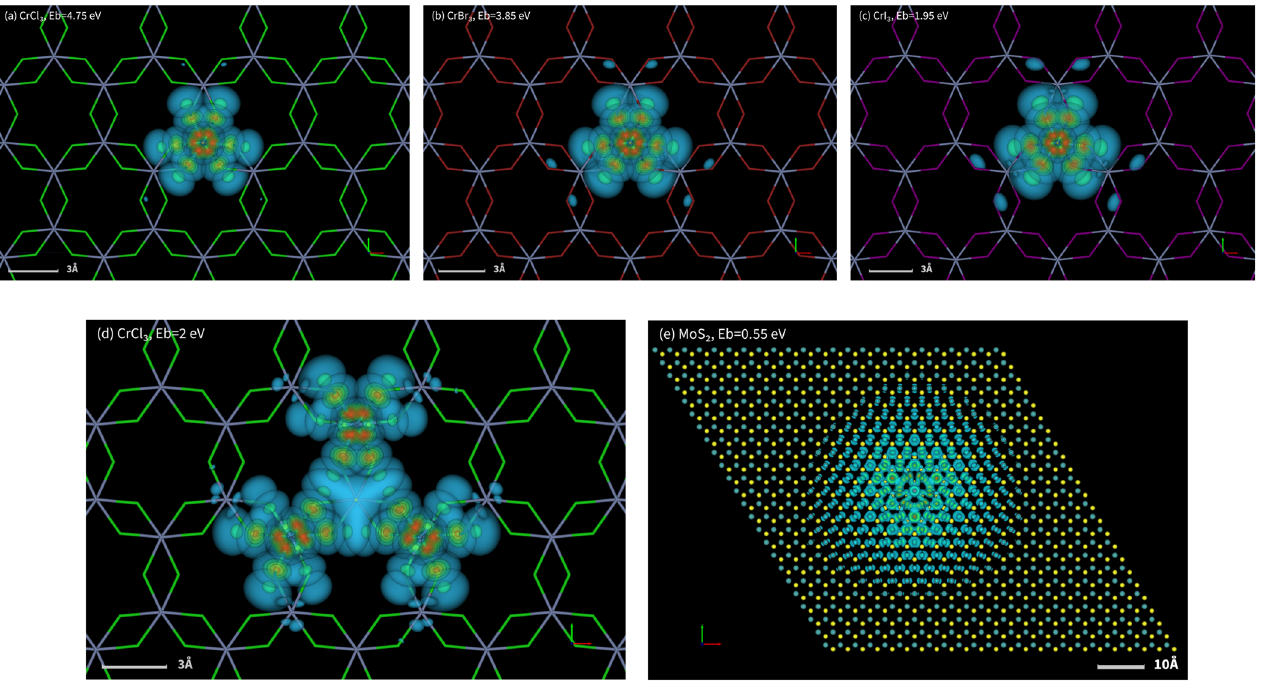
Fig. 9 Excitons in real space in CrX 3 and MoS 2 monolayers. The real-space range for the deepest lying exciton E ex 1 is shown for CrX 3 . Excitons in CrCl 3 ( a ) and CrBr 3 ( b ) have similar extent, while they are slightly more delocalized in CrI 3 ( c ) . As the binding energy reduces in CrCl 3 for the exciton with E b ~2 eV ( d ), it delocalizes over three unit cells. However, in ml-MoS 2 with E b = 0.55 eV ( e ), exciton is signi fi cantly more